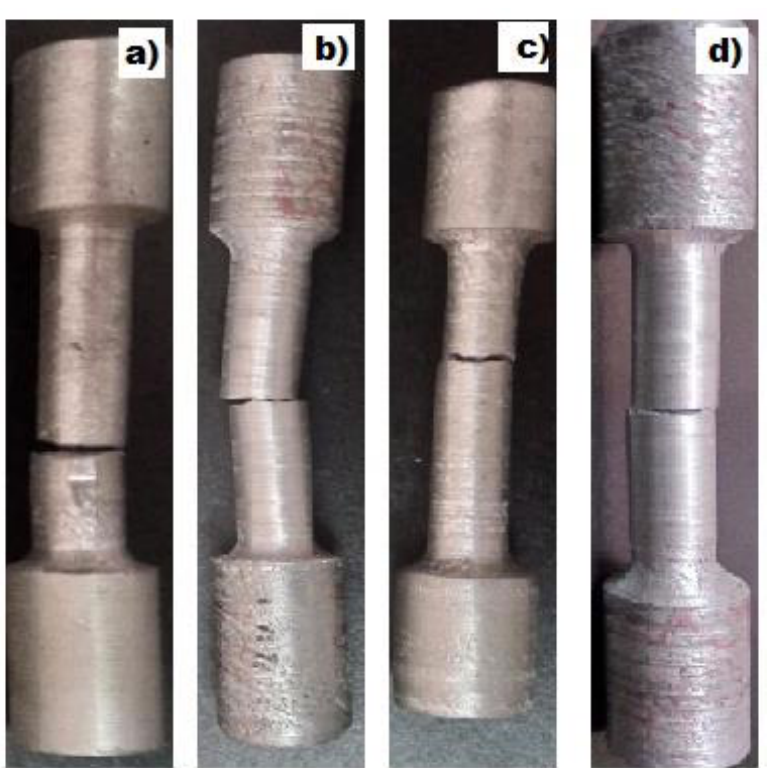
Figure 23. Tensilestrength test specimens of spray forming processing techniques of Si-Al alloy matrix reinforced with ( a ) 0% ( b ) 5% ( c ) 10% ( d ) 15% ZrO 2 particulates for 13 wt.% Si.